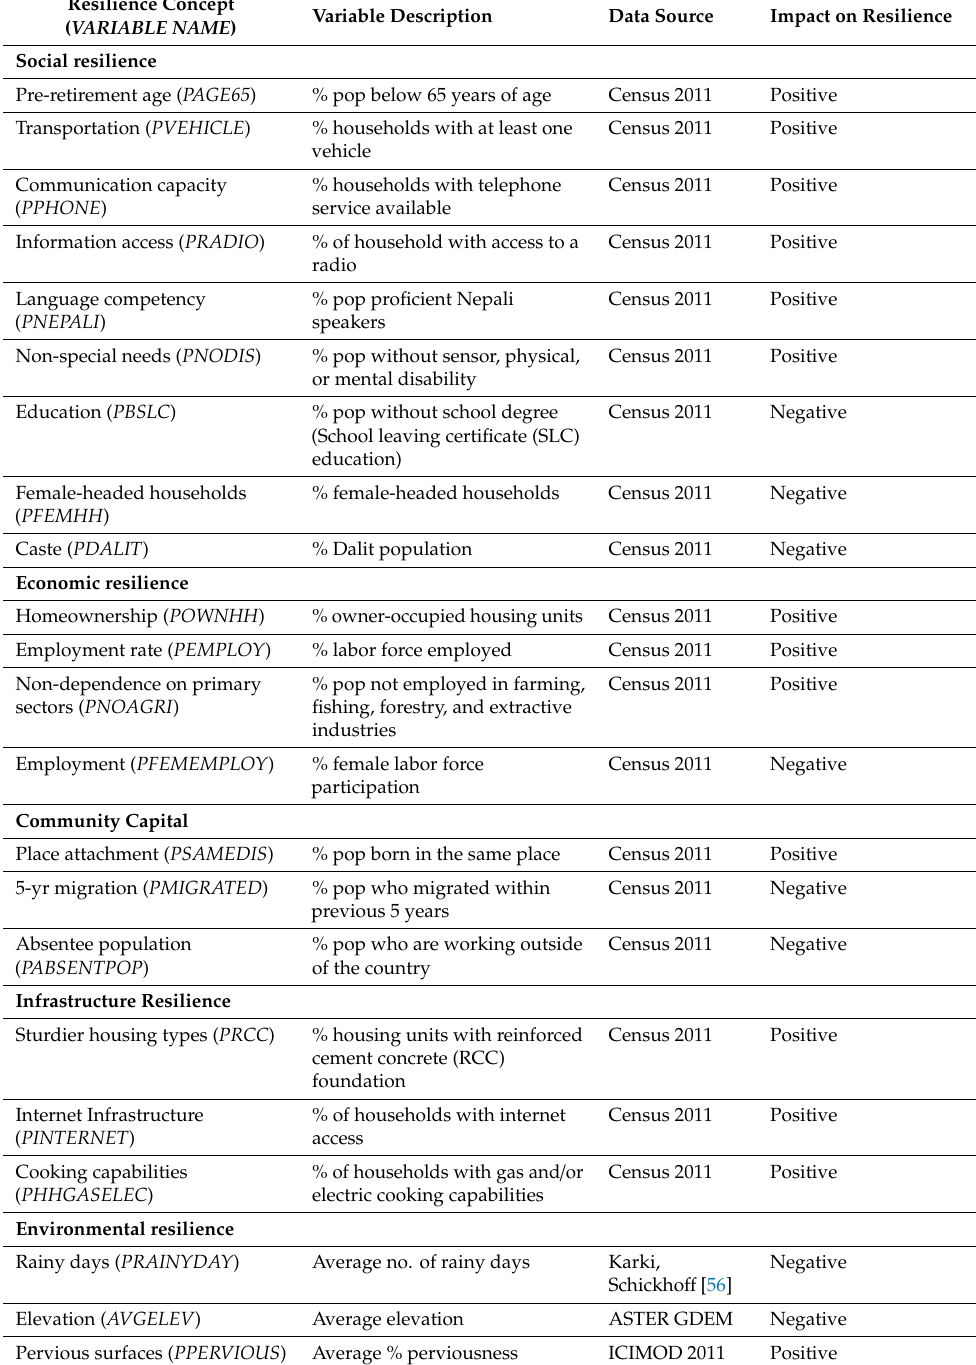
Table 3. List of variables used in resilience